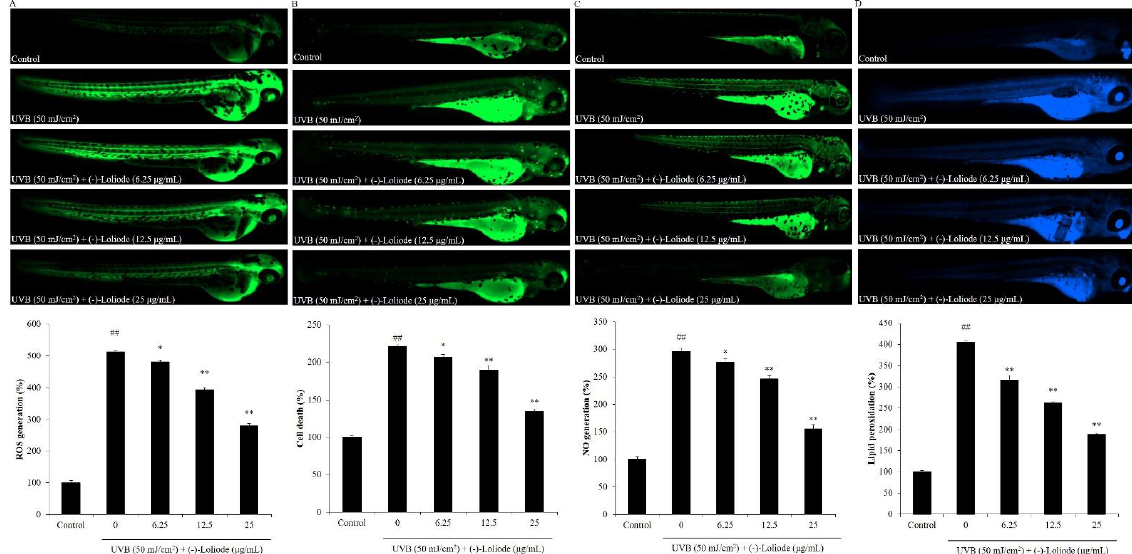
Figure 6. (-)-Loliode protects zebrafish against UVB-induced damage. ( A ) ROS generation of UVB-irradiated zebrafish; ( B ) cell death of UVB-irradiated zebrafish; ( C ) NO production of UVB-irradiated zebrafish; ( D ) lipid peroxidation of UVB-irradiated zebrafish. The relative fluorescence intensities of zebrafish were determined using Image J software. The data were expressed as the mean ± SE (n = 3). * p < 0.05 and ** p < 0.01 as compared to the UVB-irradiated group, and ## p < 0.01 as compared to the control group.